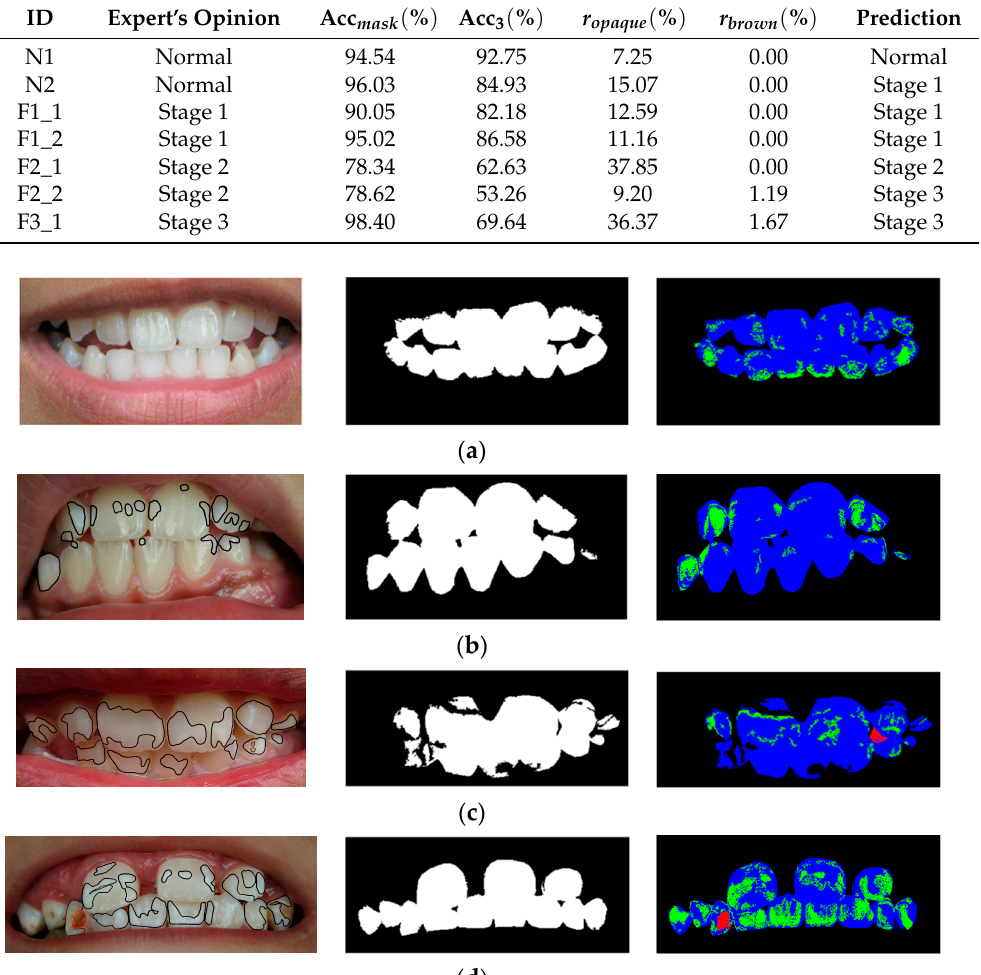
Table 5. Segmentation performance on each image in the training set, the percentages of opaque and brown pixels, and the comparison between predicted fluorosis stage vs. expert’s opinion.